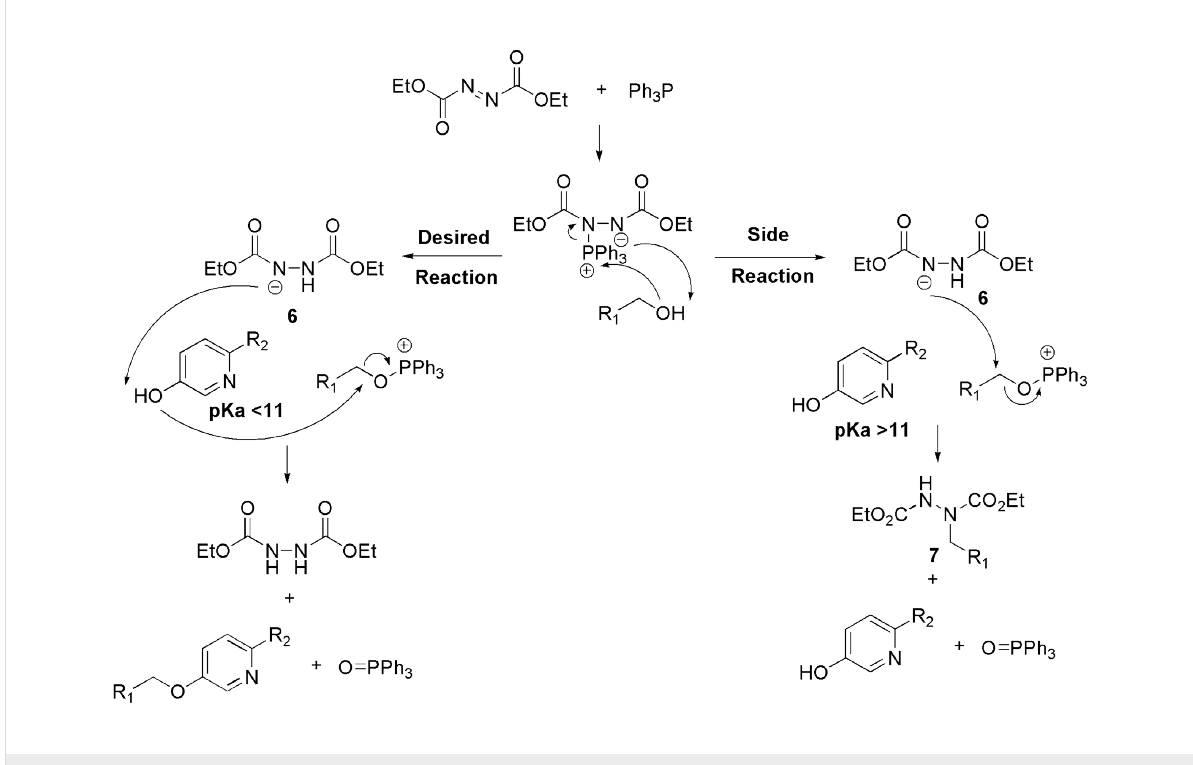
Our first attempt at the Mitsunobu reaction between pyridinol 2 and alcohol 3 , utilizing a modification of the conditions origin- ally reported by Mitsunobu,[18] afforded pyridyl ether 4 in 54% yield (Scheme 1). Interestingly, the reaction did not reach completion and pyridinol 2 was recovered, despite the fact that it was the limiting reagent. Upon closer examination, compound 5 was observed as a major by-product (46% based on 3